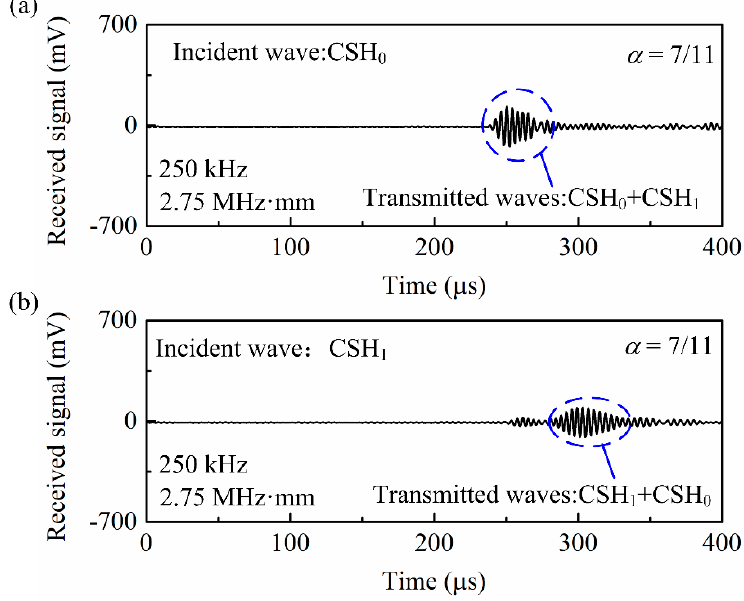
Figure 13. Experimental wave signals showing the transmission from a 7-mm deep rectangular notch.